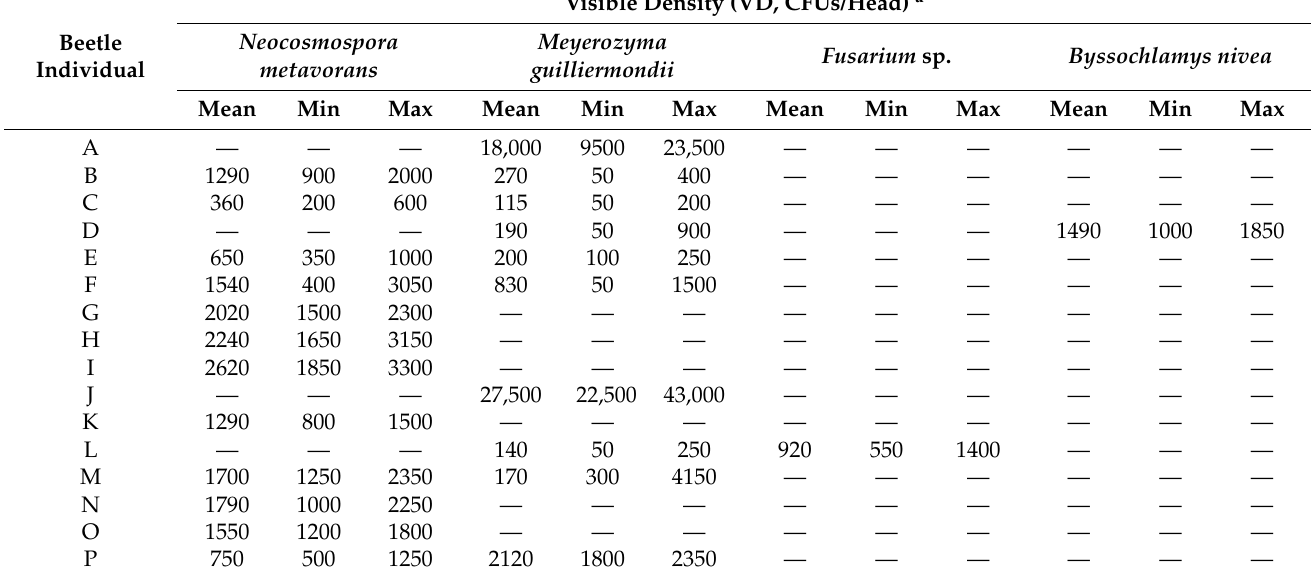
Table 2. Visible density (VD, CFUs/head) of associated fungi isolated from the head of reared female adults Euwallacea